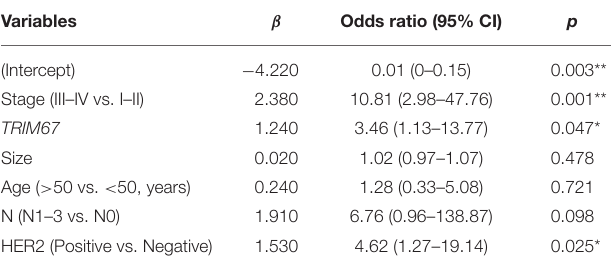
TABLE 3 | Included variables of the nomogram-based